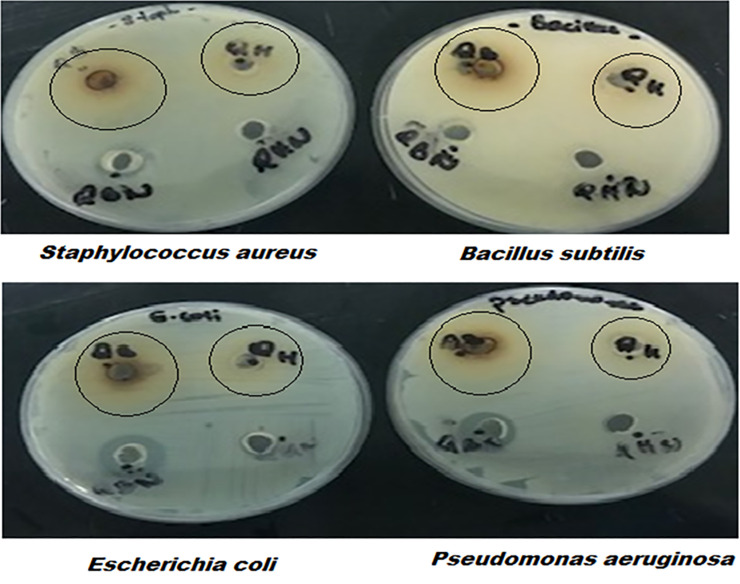
Antimicrobial activity of MgONPs synthesized by S. costus (Qustal hindi and Qustal bahri) against four bacterial strains.